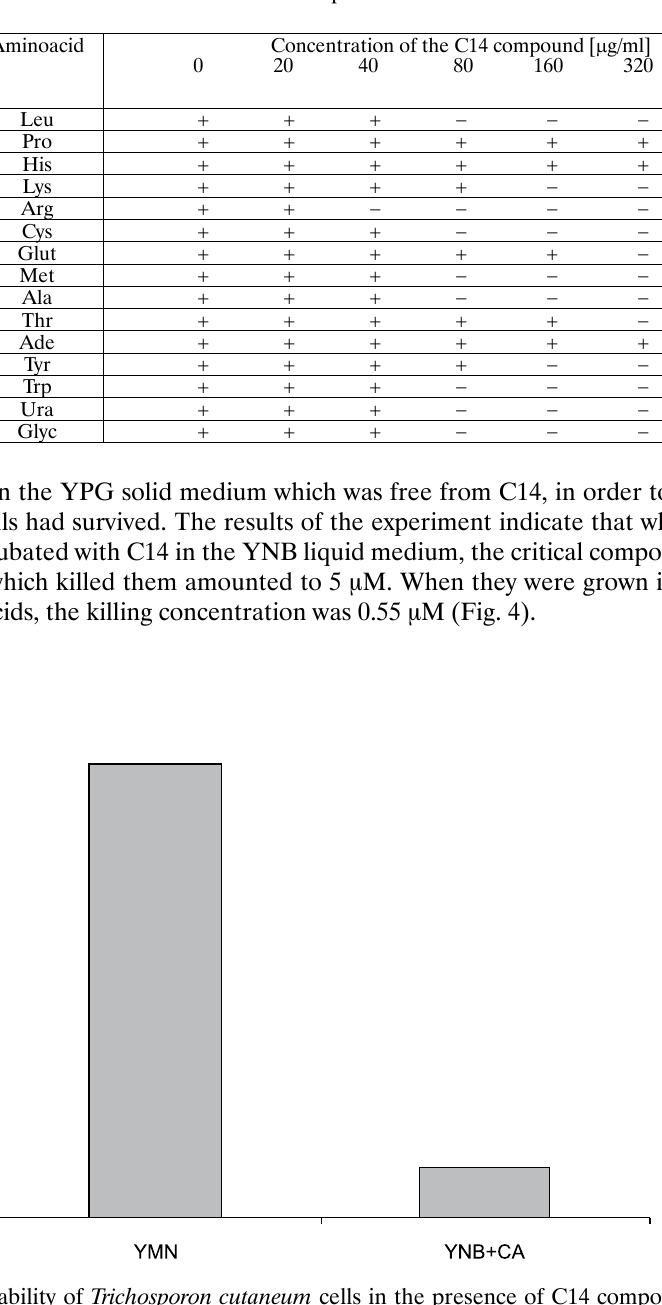
Growth of T. cutaneum on YNB suplemented with C14 and an aminoacid